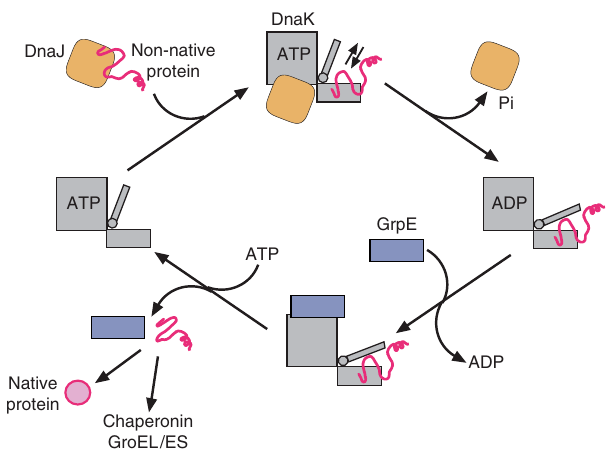
Fig. 1 Dnak/DnaJ/GrpE reaction cycle. DnaJ captures the substrate protein and transfers it to DnaK in the ATP-bound state. DnaJ and substrate synergistically trigger ATP hydrolysis by DnaK, thereby generating a stable complex between the substrate and DnaK in the ADP-bound state. Catalysis of ADP-ATP exchange by GrpE stimulates client release and regenerates DnaK-ATP for another round of client engagement. Figure modi fi ed from ref. 68